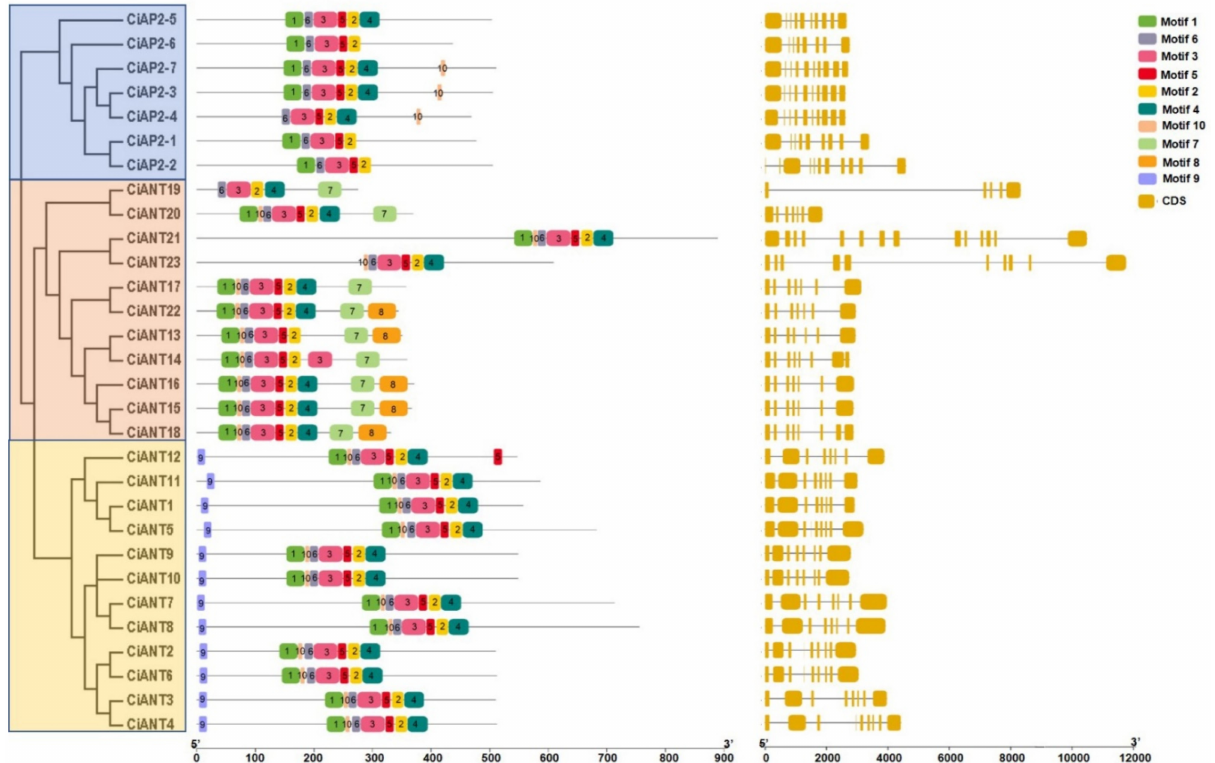
Figure 3. The motif distribution and gene structure of AP2 subfamily proteins in pecan. The middle panel represents the distribution of conserved motifs in CiAP2 proteins. The color blocks represent different motifs on proteins. The right panel represents the structure of CiAP2 genes. The green blocks represent